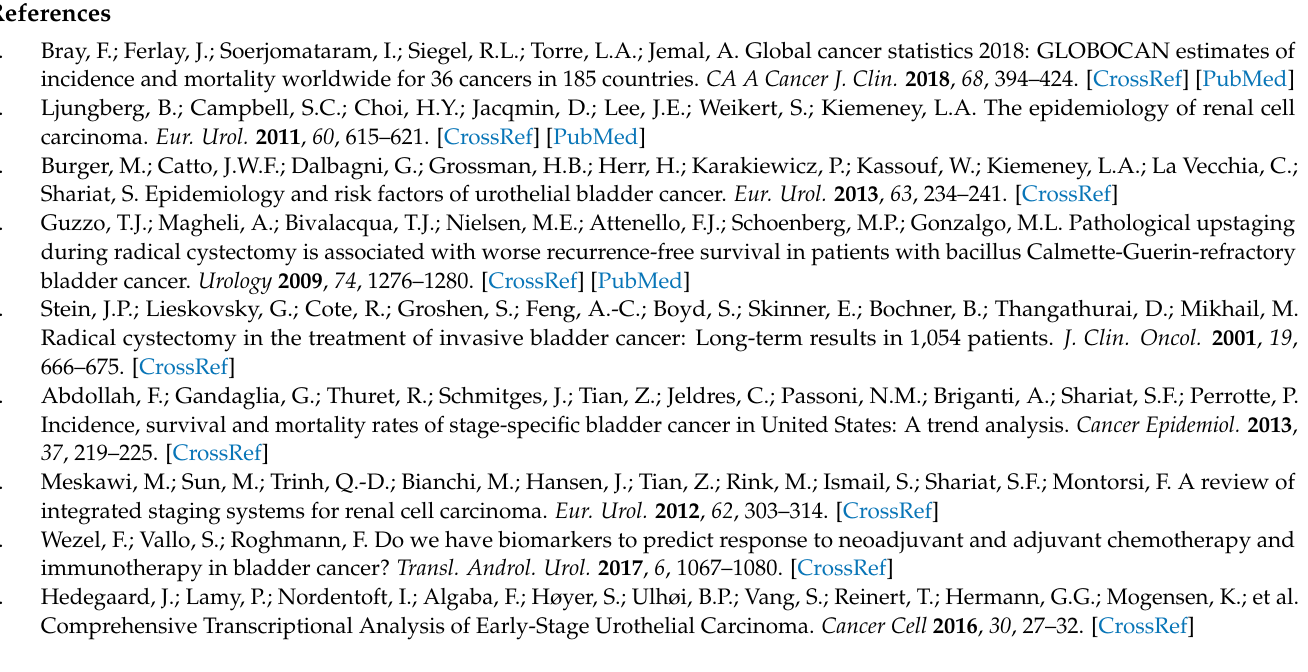
RTL; Figure S3: Kaplan-Meier survival analysis of BC overall survival in correlation with long and short RTL groups; Figure S4: Kaplan-Meier survival analysis of patients with ccRCC in correlation with long and short RTL groups; Table S1: Buffers for DNA ex-traction; Table S2: Demographic and clinical characteristics of the ccRCC subgroup population; Table S3: Univariate and multivariate cox regression survival analysis of prognostic factors of